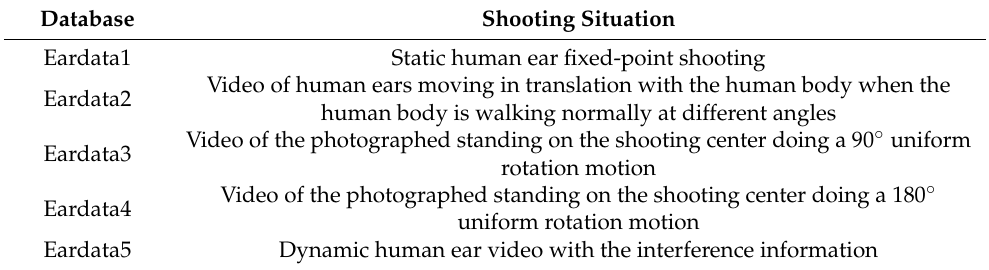
Table 2. Human ear database information.